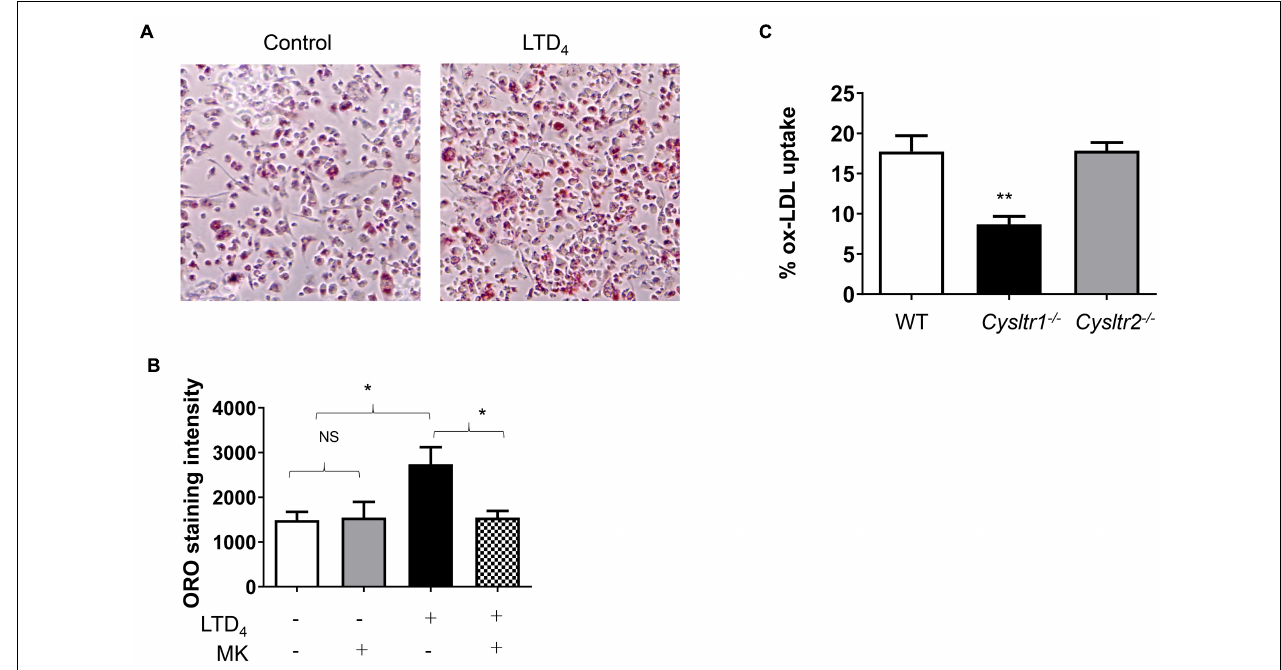
FIGURE 3 | Cys-LTs induce oxLDL uptake in macrophages. Representative images showing oxLDL uptake in macrophages. Cells were treated with 0.5 µ M LTD 4 for 24 h in the presence or absence of CysLT 1 R antagonist MK (1 µ M) and then incubated with oxLDL for 1 h. Thereafter, cells were stained with oil red-O (ORO), imaged and quantified using ImageJ. (A) Images of control and LTD 4 -treated cells depicting positive ORO staining, (B) quantification of ORO staining in macrophages pre-treated with or without MK and treated with or without LTD 4 . (C) Bone marrow cells were isolated from WT, Cysltr1 - / - , and Cysltr2 - / - mice and then cultured for 6 days with M-CSF to differentiate them into macrophages. BMDMs were incubated with fluorescently labeled oxLDL for 1 h and the oxLDL uptake was measured by analyzing the fluorescence incorporated into the cells using BioTek microplate reader. Results shown are mean ± SEM from three separate experiments (one-way ANOVA followed by post hoc Tukey multiple comparison test, * p ≤ 0.05, ** p ≤ 0.01, ns = not